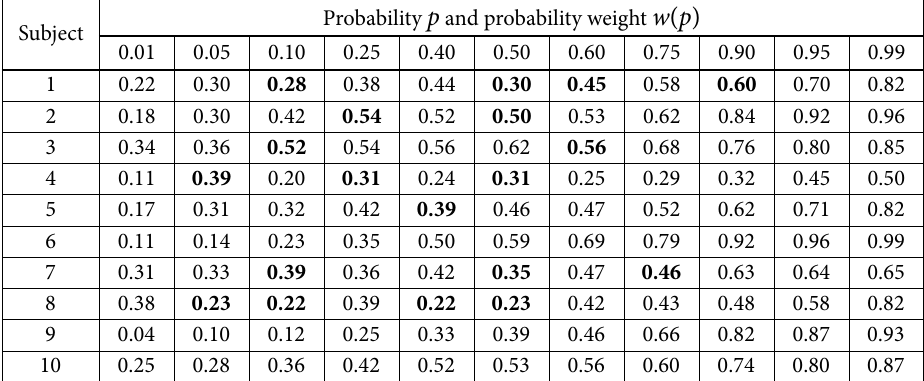
Table 5. Experimental data from Gonzalez and Wu (1999 ) Probability p and probability weight w ( p Subject